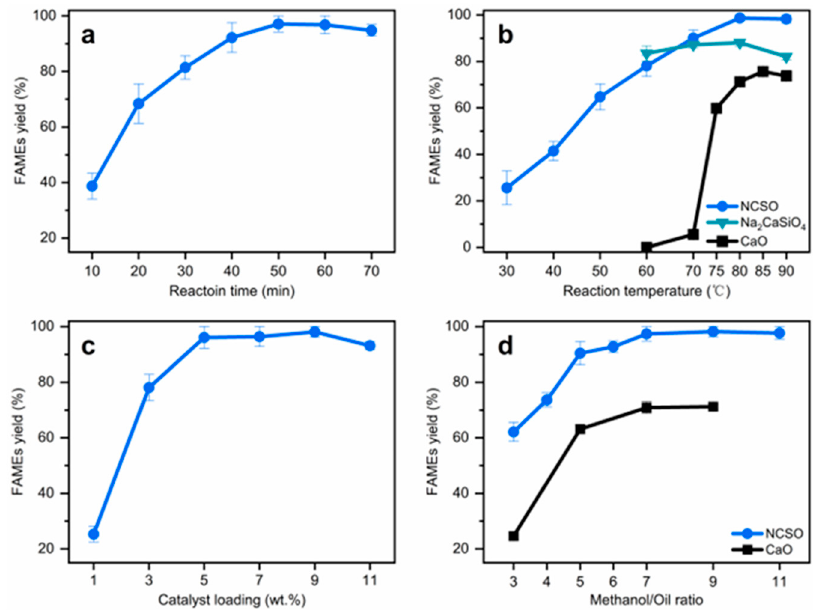
Figure 3. Effect of different reaction parameters on the transesterification reaction using NCSO: ( a ) reaction time; ( b ) reaction temperature; ( c ) catalyst loading; ( d ) methanol/oil molar ratio.